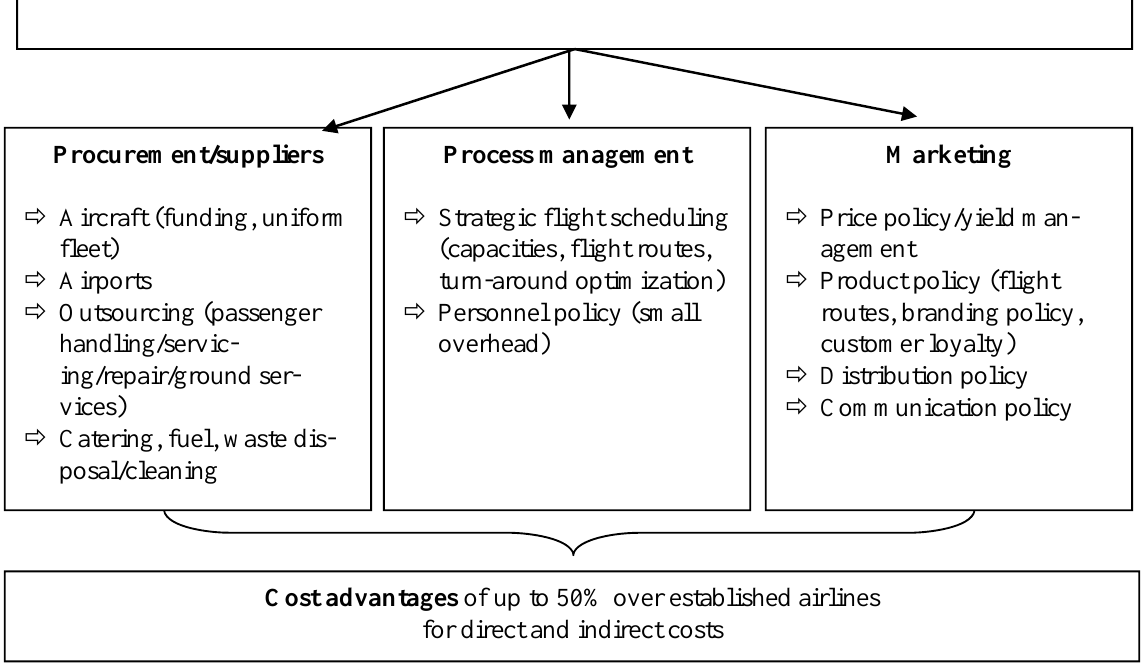
Figure 5. The Business Model of (European) Low Cost Carrier Source: Gross and Schroeder (2007, p.